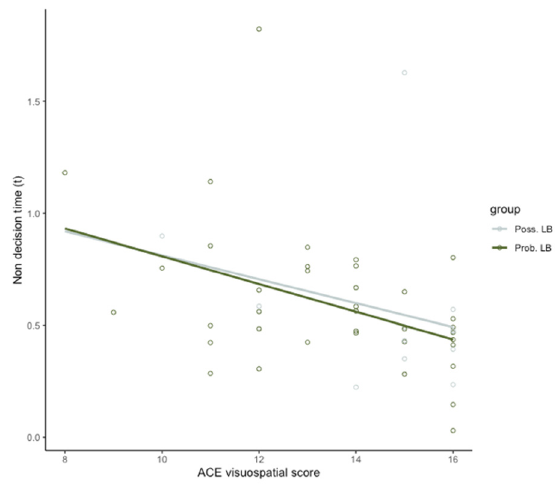
Figure 4. Non-decision time (t) is negatively related to scores on the Addenbrooke’s Cognitive Exam (ACE) Visuospatial subscale in mild cognitive impairment (MCI-LB) groups (adj R 2 = 0.129, beta = − 0.333, p = 0.014).